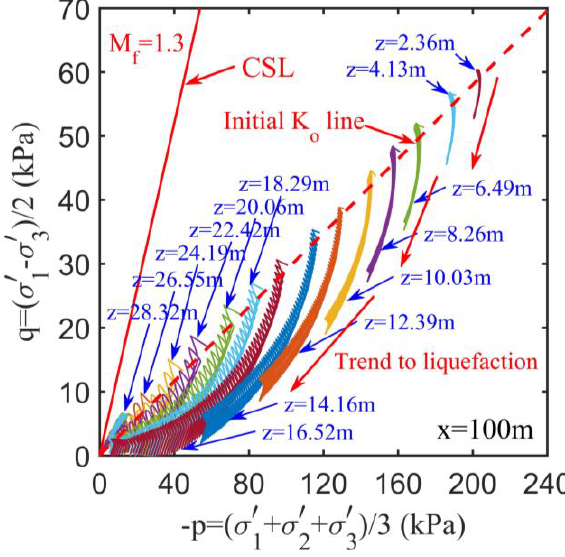
Figure 6. Cnoidal wave-induced stress paths at a series of buried depths on x = 100 m.